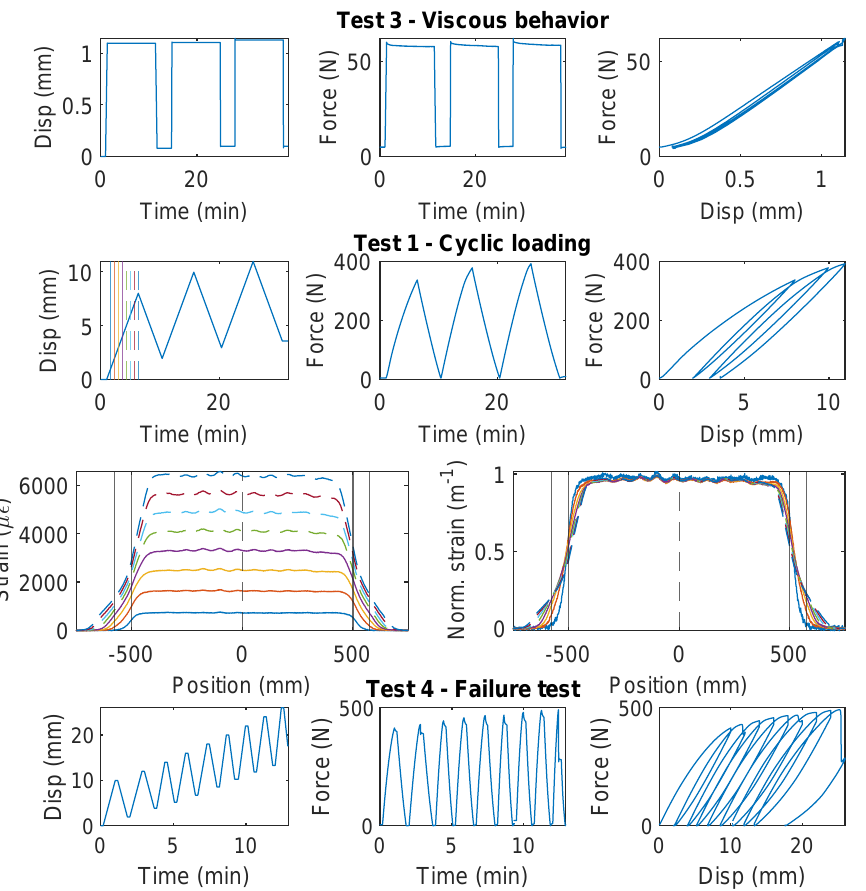
Figure 16. The loading protocol, force–displacement relation and strain distributions under increasing displacement levels (represented by different color lines) for Specimen 2 of the PA-Steel 3.2 mm